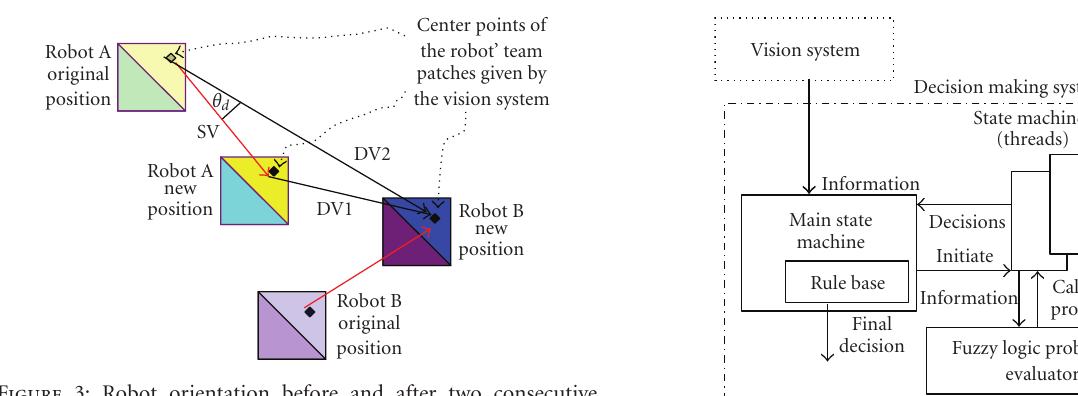
Figure 3: Robot orientation before and after two consecutive frames.